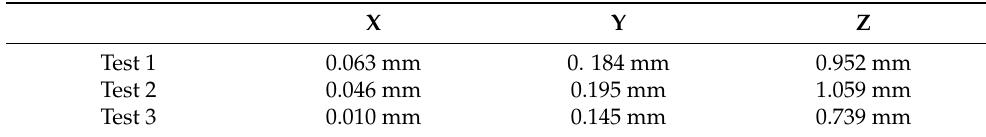
Figure 9. Workpiece target path vs. computed trajectory. Table 4. Trajectory RMSE error for V-type butt Table 4. Trajectory RMSE error for V-type butt joint.